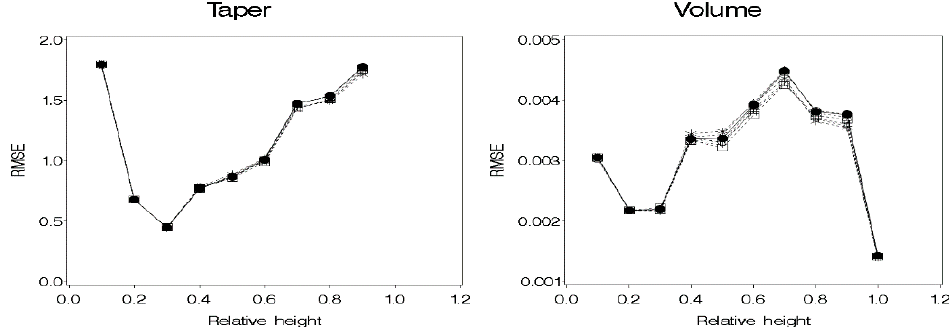
Figure 2. Root mean square error (RMSE) by relative height classes for diameter and volume pre- dictions using Clark model with and without crown variables for Dahurian larch.